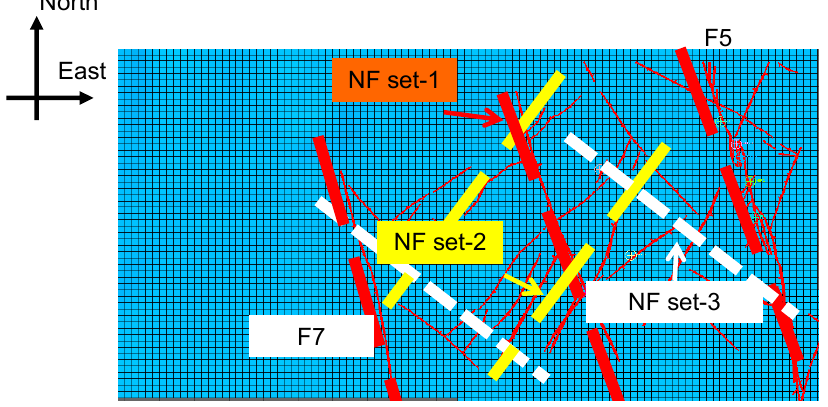
Figure 4. Plane view of natural fractures (NF) at T74 interface and illustration of classification.